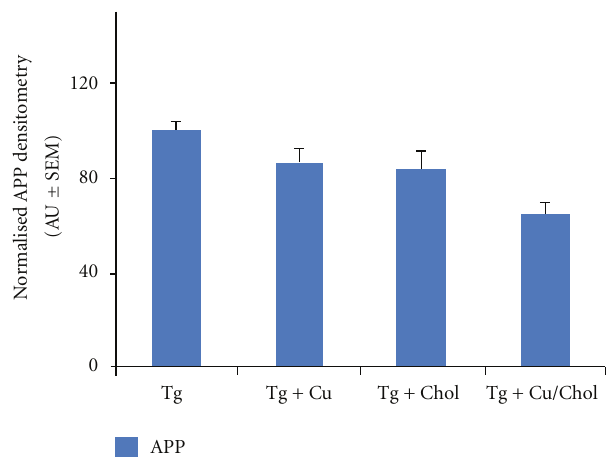
Figure 2: Assessment of APP levels in APP/PS1 mice by Western blot. There is a significant reduction in APP levels in the transgenic mice that received both a high-copper and a high-cholesterol diet, as compared to the Tg control group (Tg).